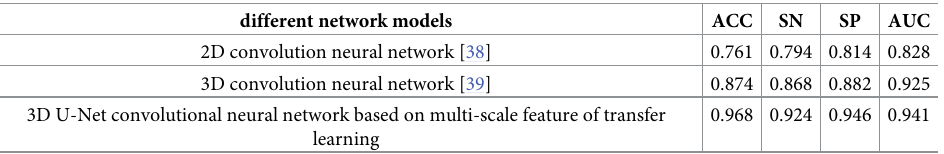
Table 9. Results of different network models on